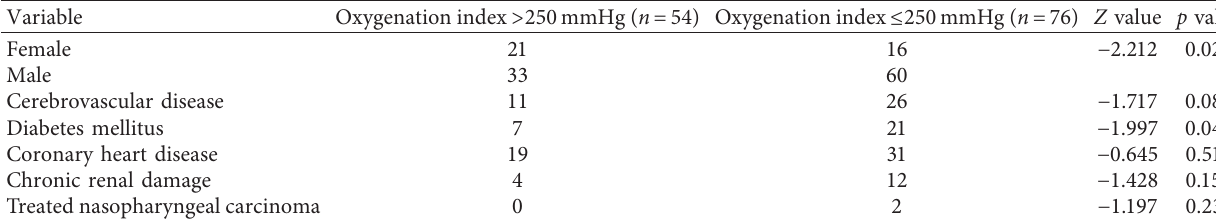
Table 1: Gender and comorbidities.